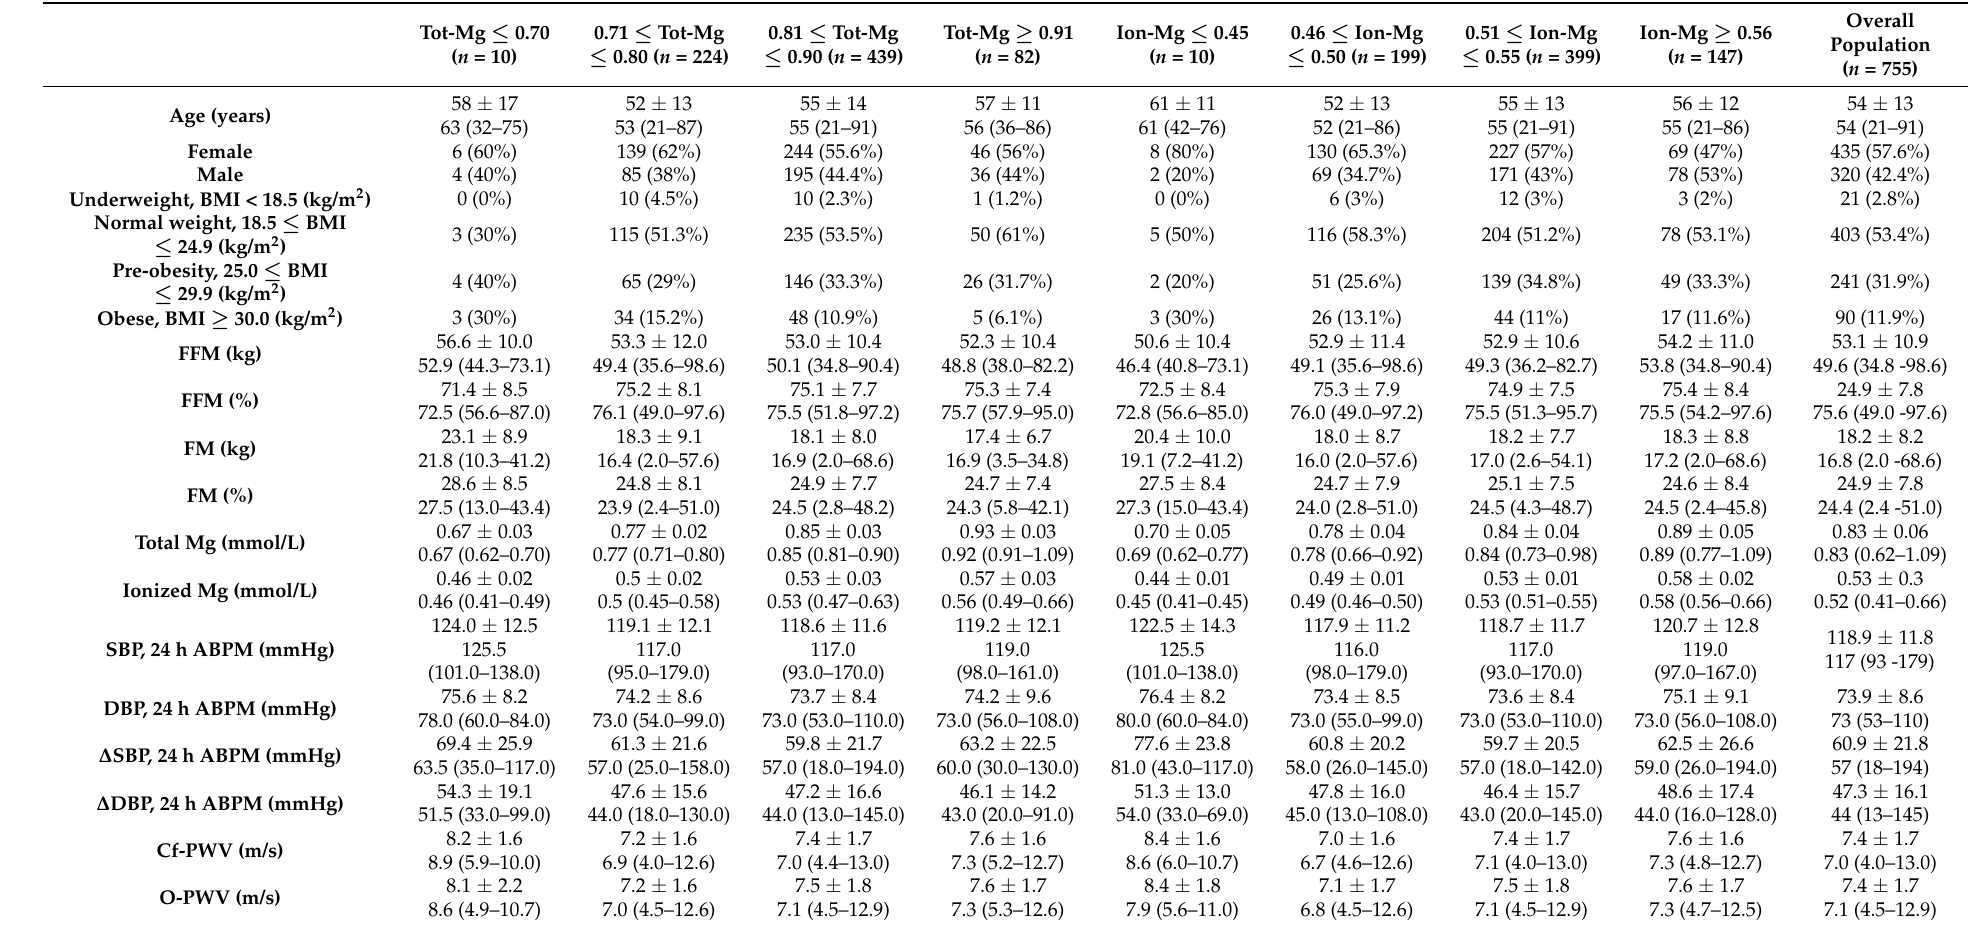
Table A1. Patients’